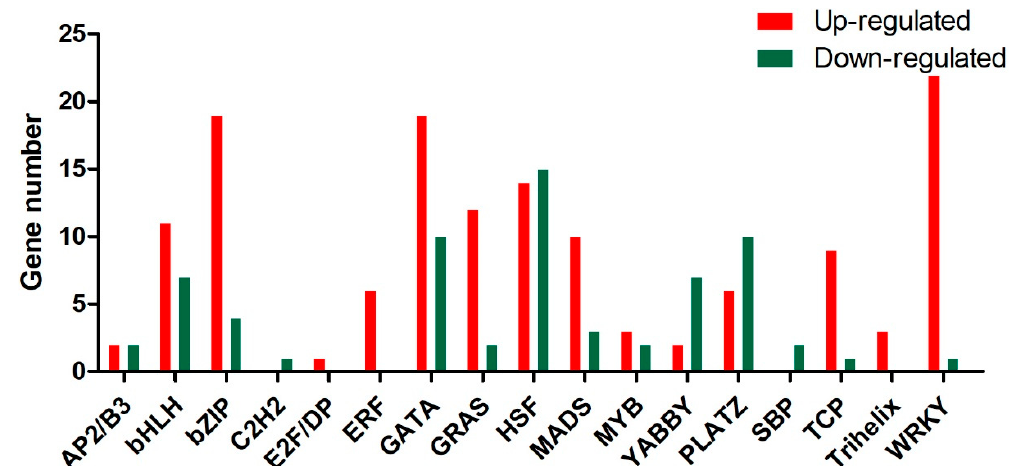
Figure 12. Differentially expressed transcription factors involved in heat stress.